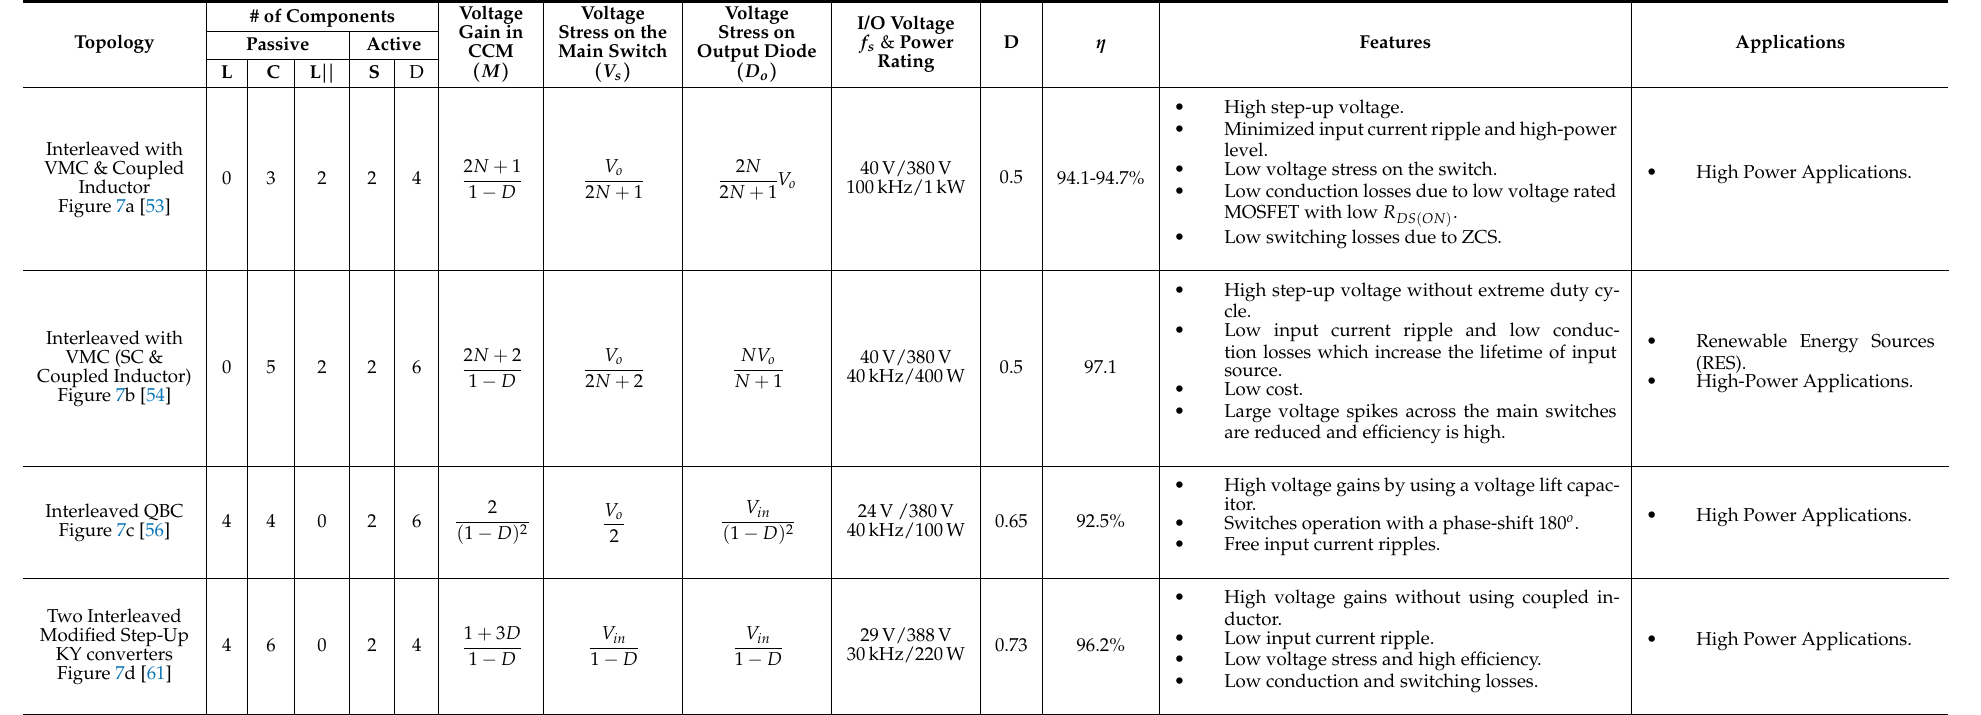
Table 3. Comparison of Interleaved Boost